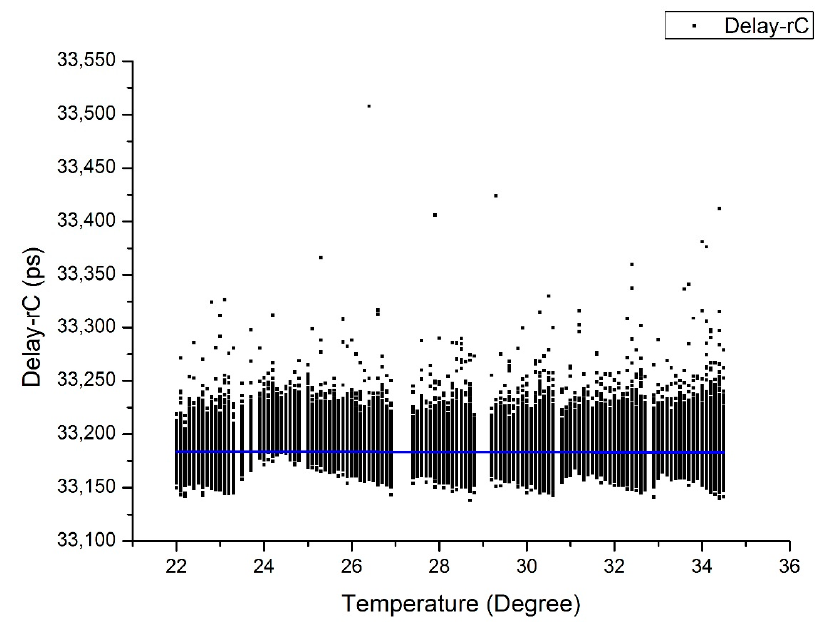
Figure 6. Delay over temperatures after compensation in the temperature rising period. (The black dots are the compensated data, and the blue line is the fitting curve.) The slope of the delay after compensation achieves − 0.054 ps/°C. The comparison of TDEV is achieves 1.76 ps from the original value of 7.74 ps for averaging time of 40,000 s.